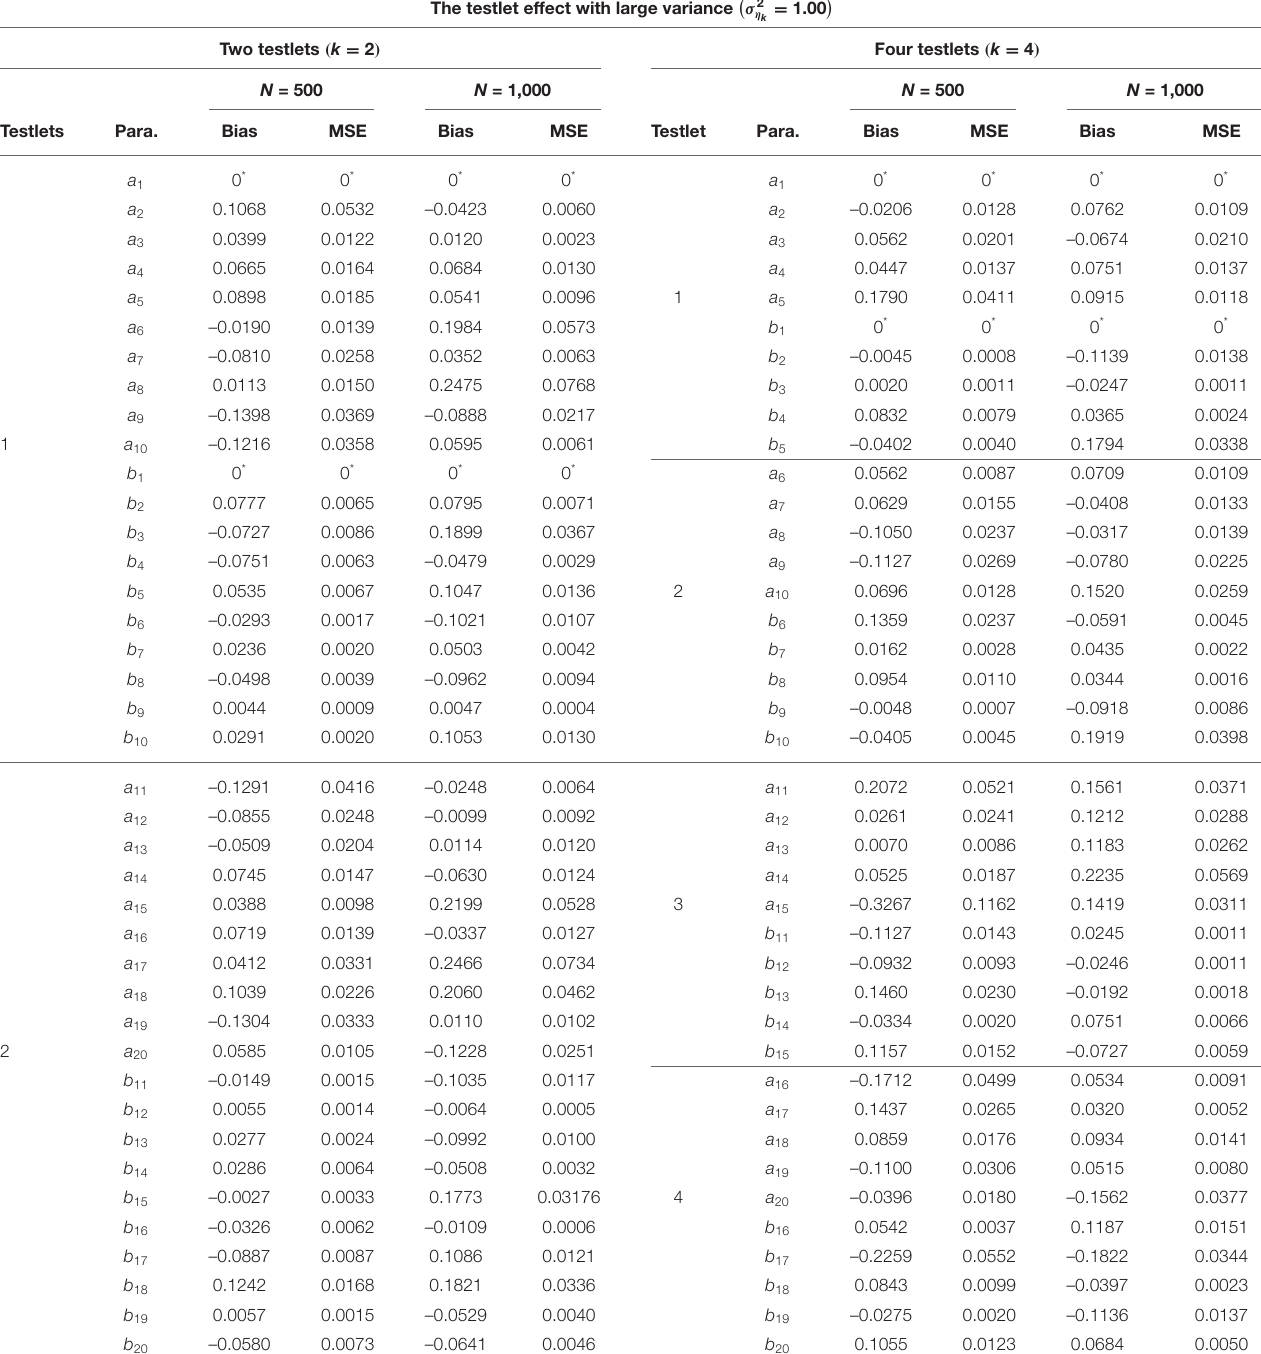
TABLE 3 | Evaluating accuracy of the item parameter estimates based on different simulation conditions in the simulation study 1. The testlet effect with large variance